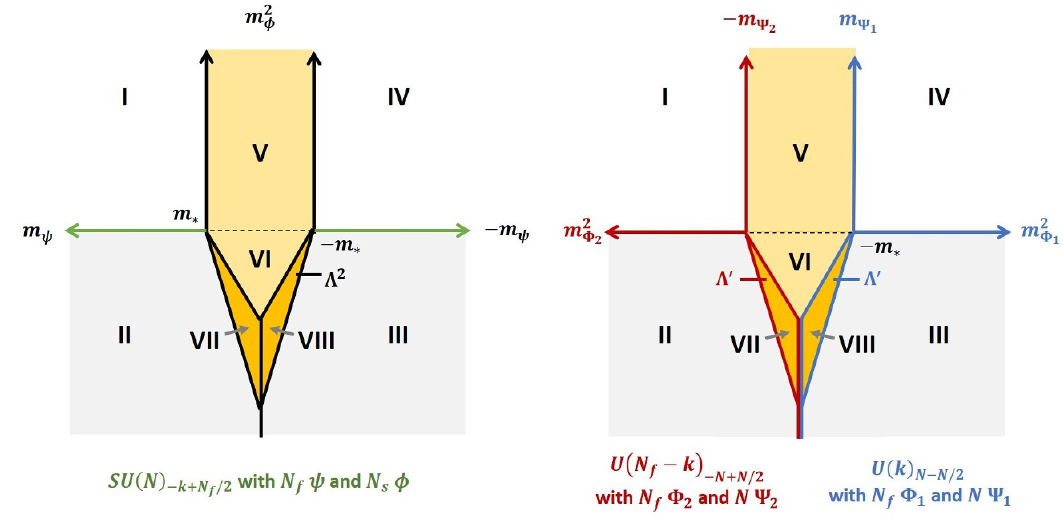
Figure 5. SU and U sides of the (cid:13)avor-violated master duality for N = N s and j k j < N f < N (cid:3) . Flavor-violation for N = N s